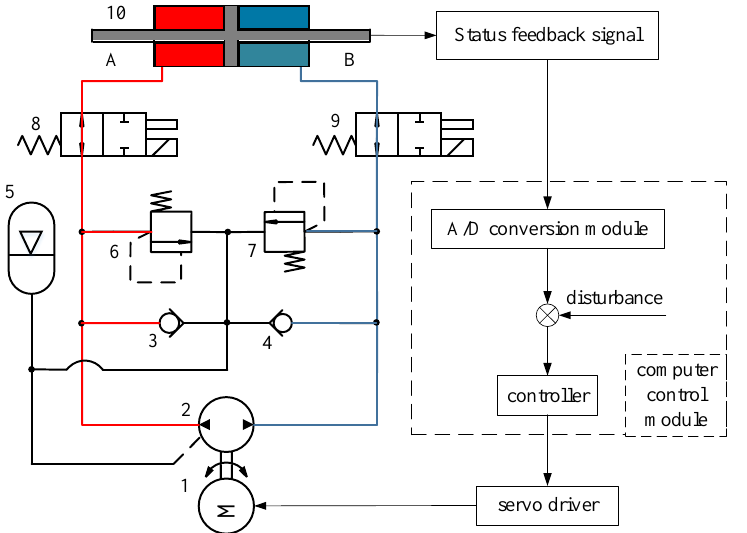
Figure 1. Schematic diagram of electro–hydraulic servo closed-pump control system. 1: servo motor; 2: fixed displacement pump; 3/4: one-way valve; 5: accumulator; 6/7: one-way valve; 8/9: solenoid directional valve; 10: hydraulic cylinder. A and B represent the two chambers of the oil cylinder